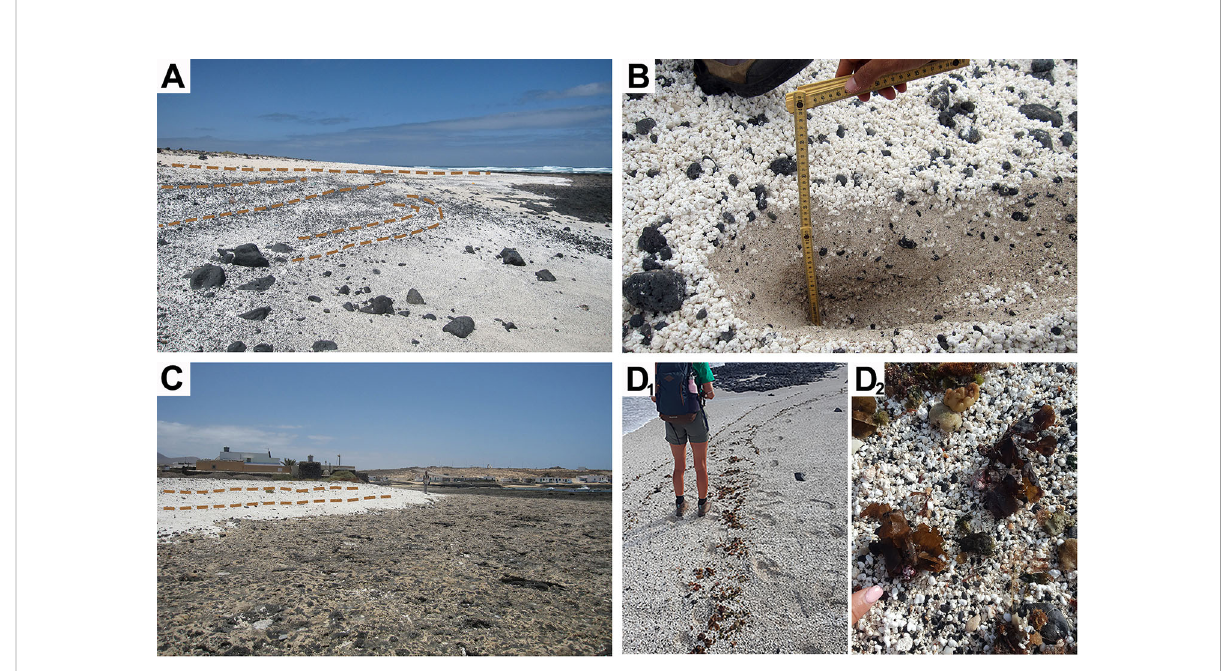
FIGURE 10 (A) Stranded rhodoliths at L2 - Caleta del Bajo de Mejillones. Image is at the far (distal end) of the 120-m long deposit; dashed lines show how the mixed basalt and rhodolith sand in successive events terminate to the west. (B) detail of small trench trench made at L2 - Caleta del Bajo de Mejillones evidencing the rhodolith drift overlying the sand. (C) Stranded rhodoliths at L3 – Majanicho. Dashed lines show layering indicated by stringers of eroded basalt. (D1) Stranded extant rhodoliths attached to brown algae at Playa El Hierro. (D2) Detail of stranded rhodoliths attached to brown